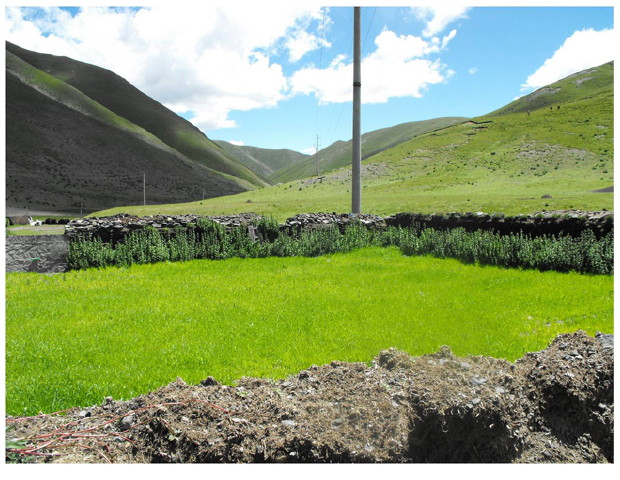
Fig. 2 . Planting forage grass to maintain forage supply.